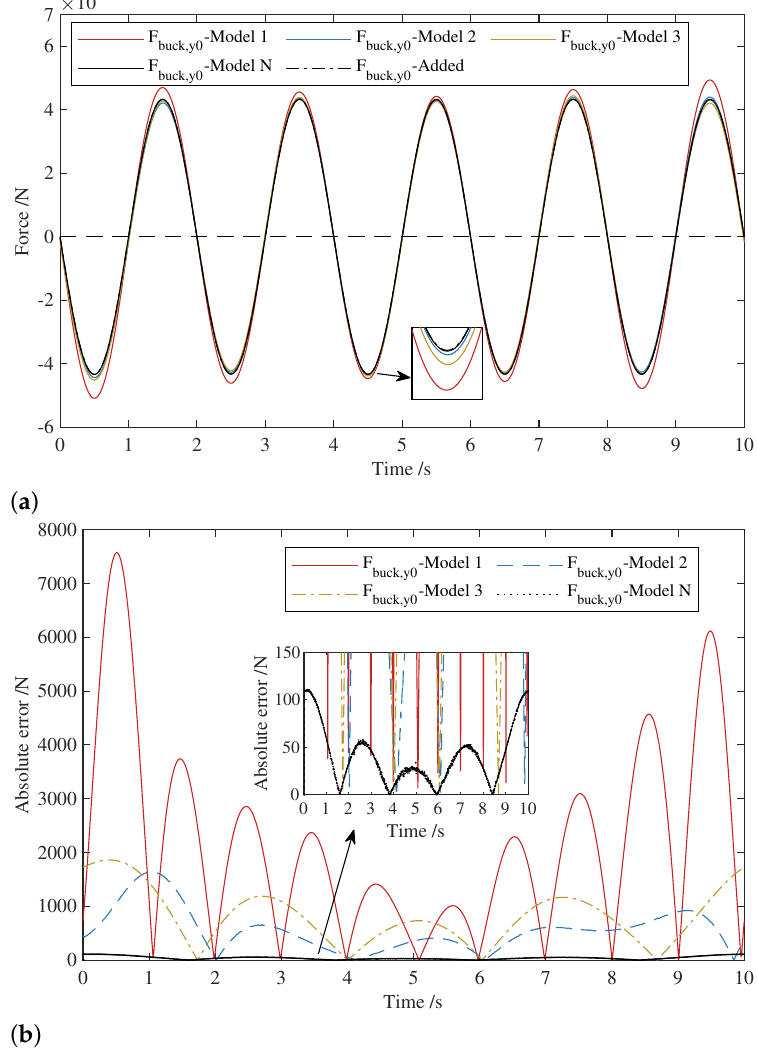
Figure 16. Comparison and error of bucket force in y direction for each model. ( a ) Comparisons in y direction between calculated bucket force and added force; ( b ) Absolute errors of calculated bucket force in the y